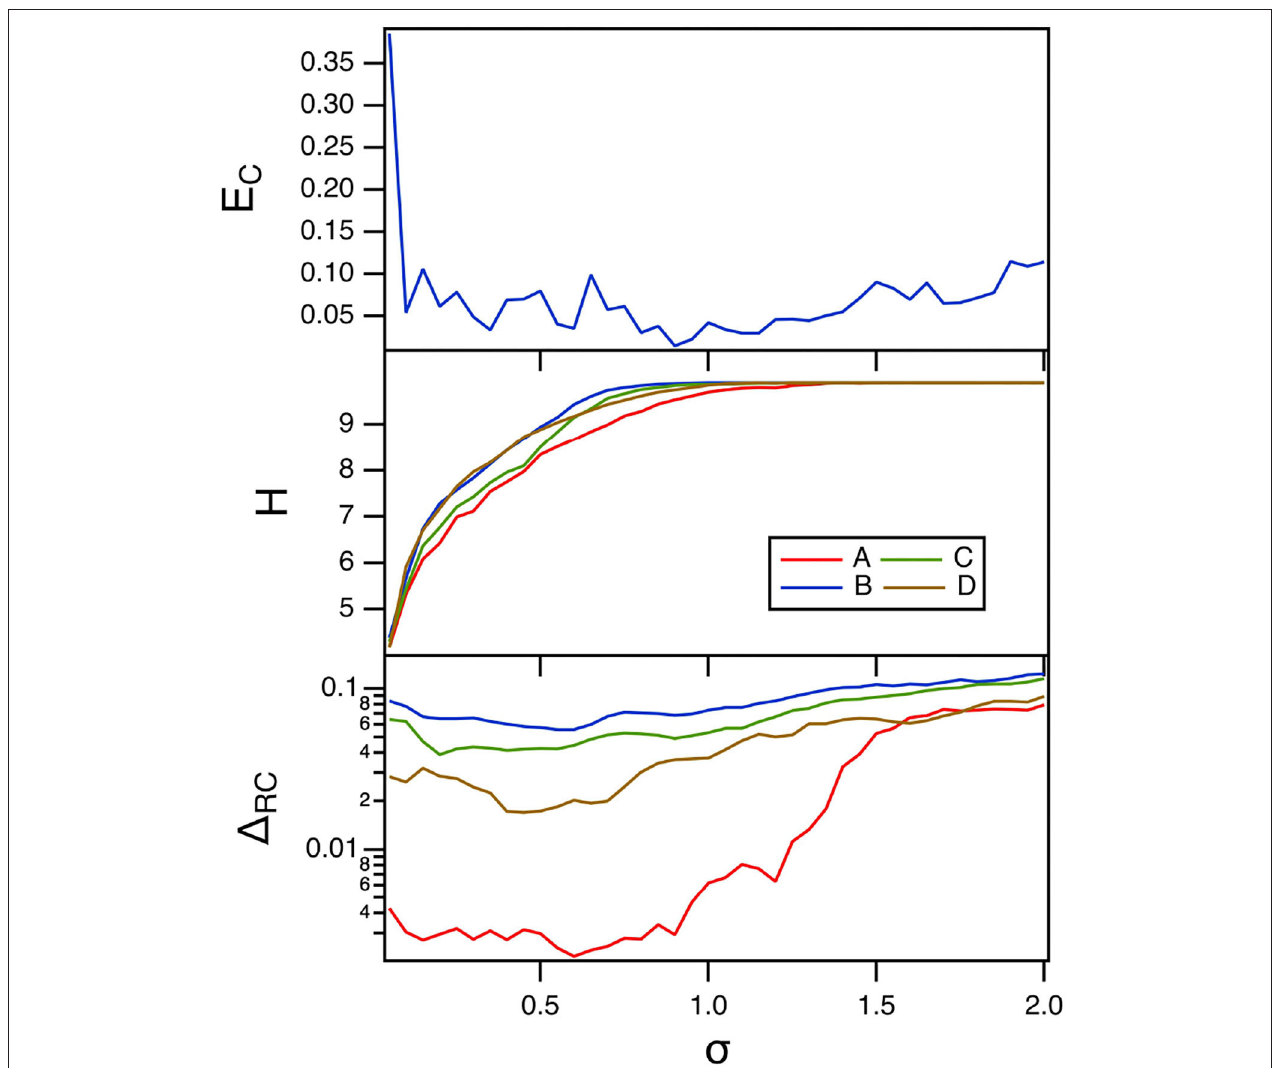
FIGURE 10 | The top plot shows the fraction of errors E C in identifying which of the four Sprott systems was present, as a function of the spectral radius σ for the polynomial ODE reservoir computer. The bottom plot shows the entropies for the four Sprott systems over the same parameter range. The training error 1 RC is shown in the bottom plot. For this plot, p 1 = − 0.5 and the time constant T 0 = 0.3.